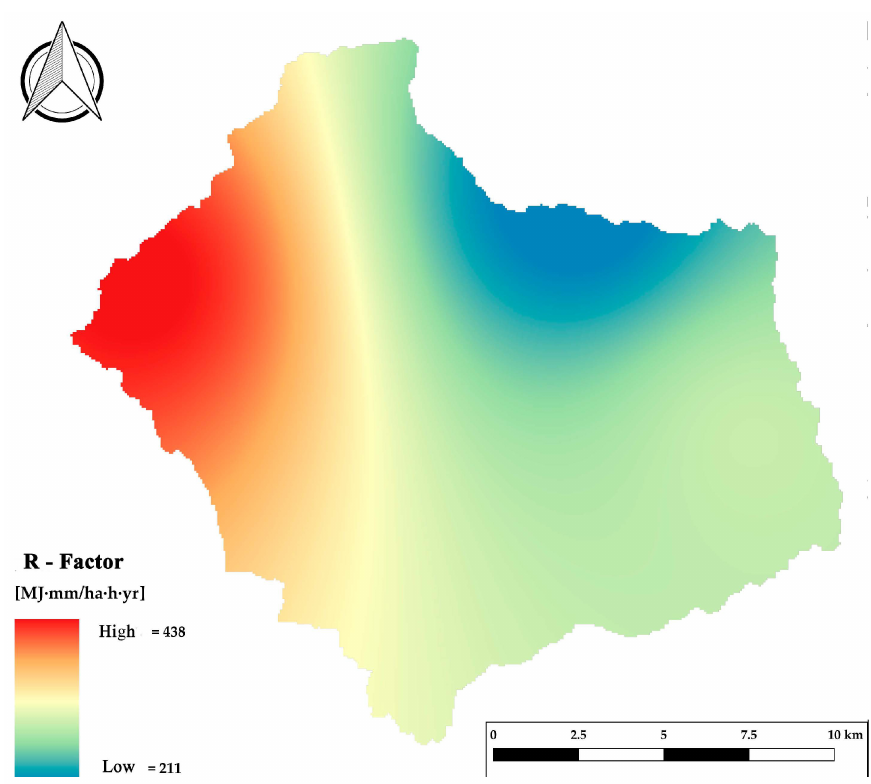
Figure 5. R-factor